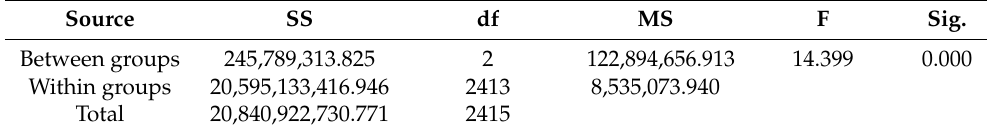
Table A3. One-way ANOVA on listening